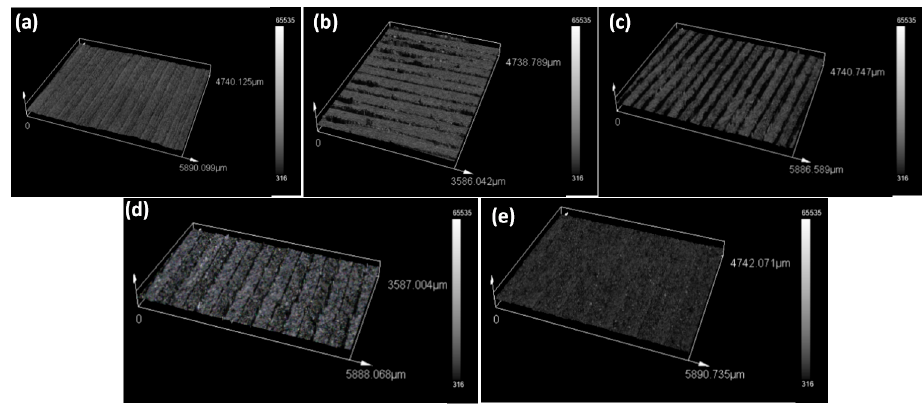
Figure 9. SEM imaging of the interfacing bonding between the layers for: ( a ) waste; ( b ) 4% Mg prints.